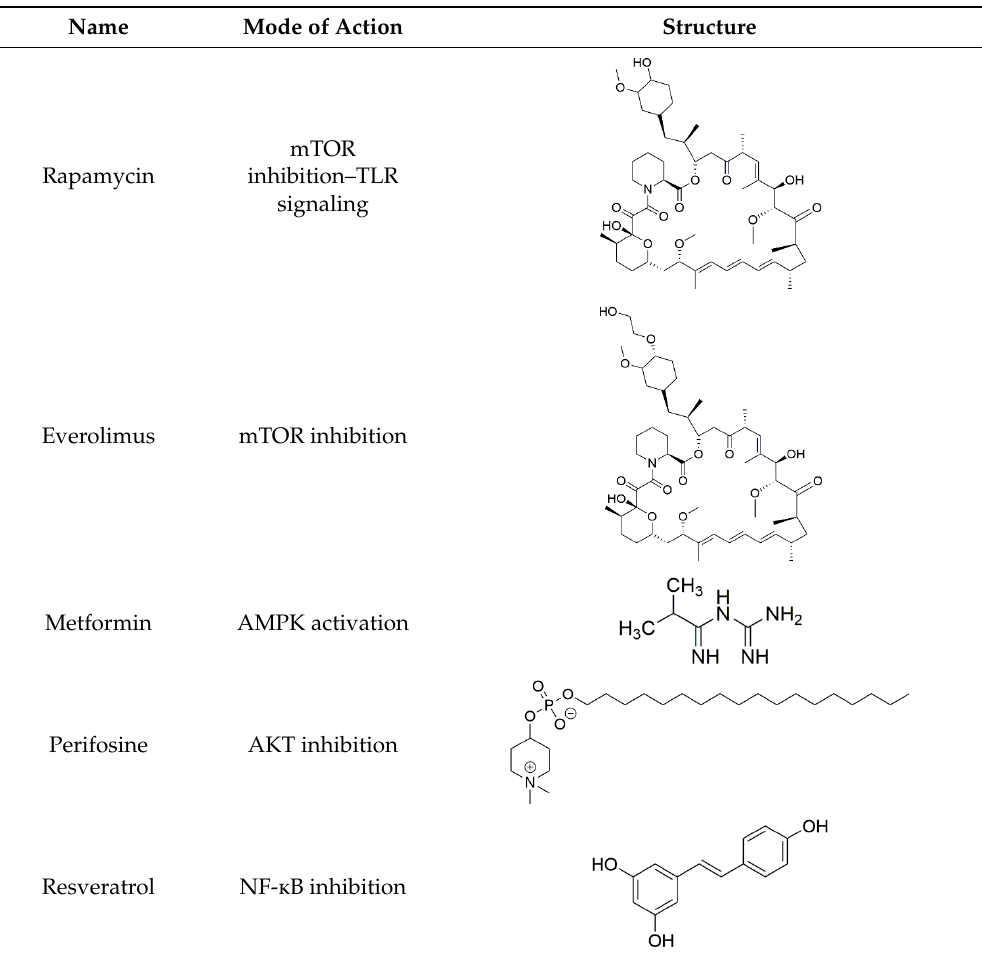
Table 3. Autophagy activators. mTOR: mechanistic target of rapamycin complex, NF-kB: nuclear factor kappa-light-chain-enhancer of activated B cells.